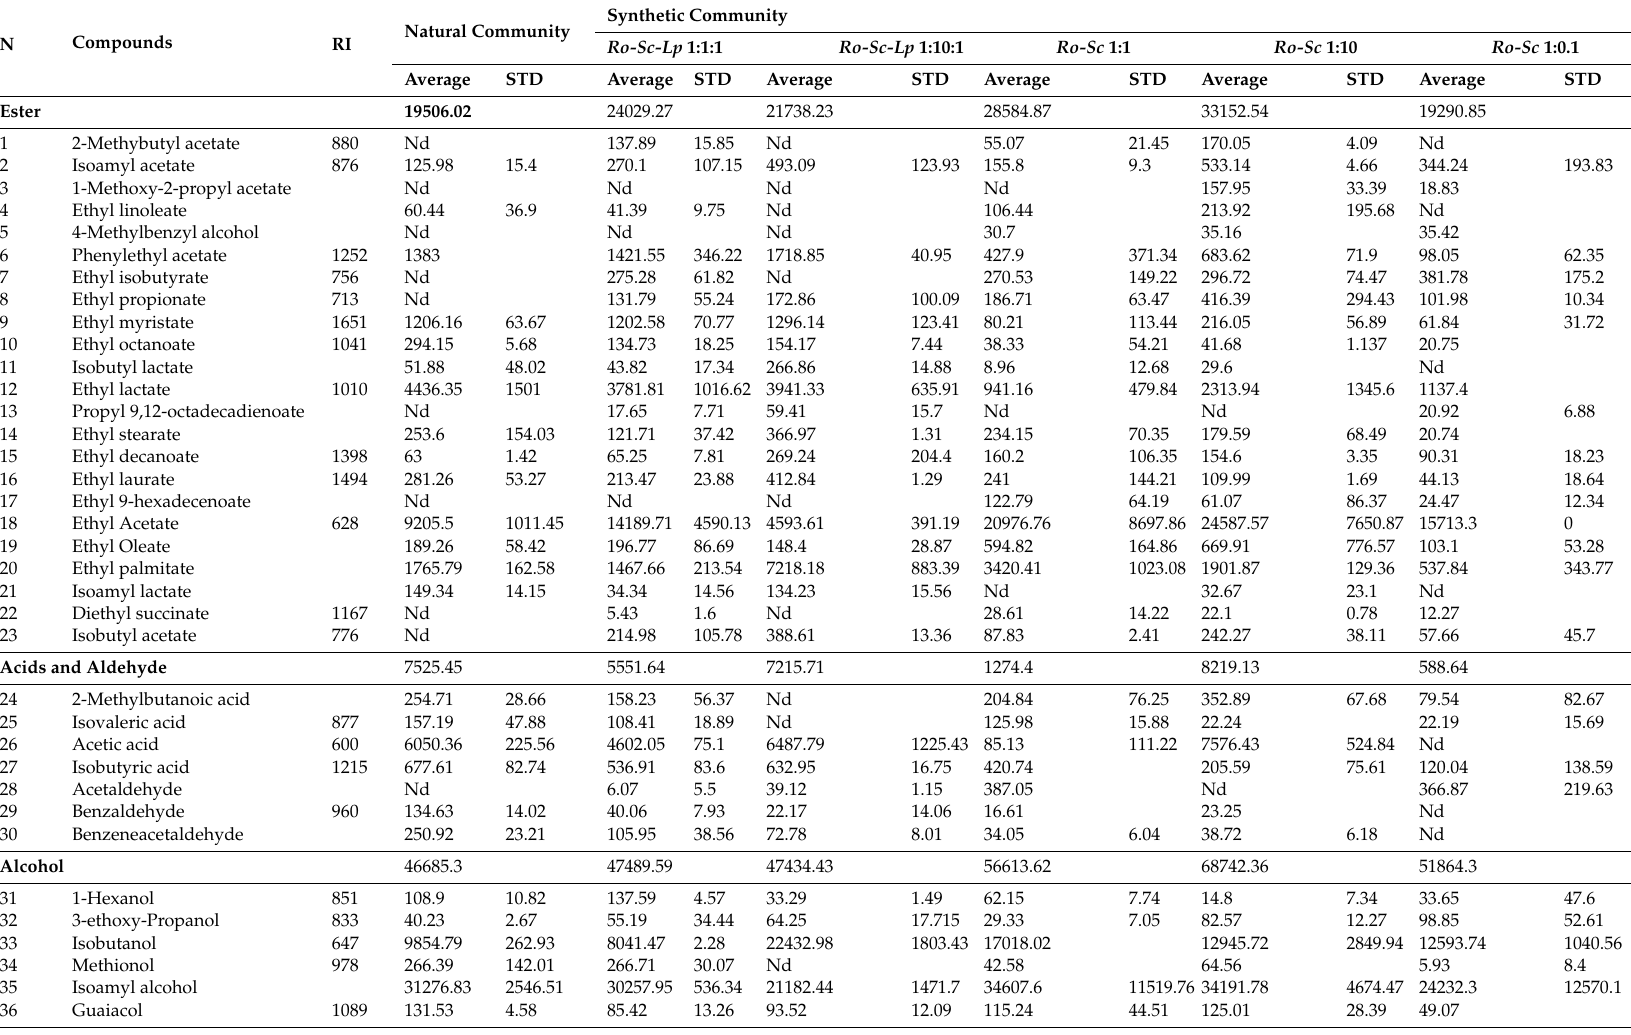
Table 2. Flavor compounds ( µ g / L) produced from the natural community and a combination of strains as the synthetic communities in the red rice wine brewing process.